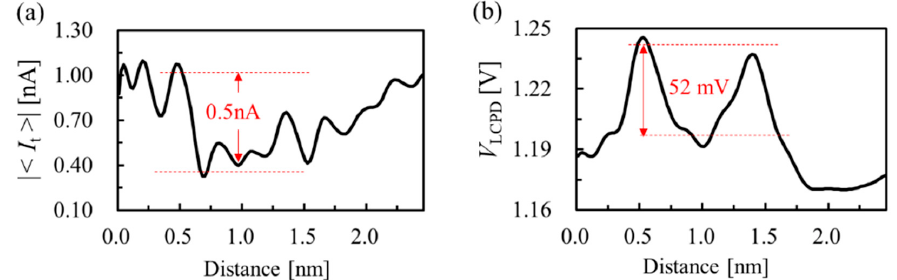
Figure 5. Multiple images of TiO 2 (110) surface with atomic resolution and corresponding line profiles. ( a ) Frequency shift ( ∆ f ) image, ( b ) tunneling current ( < I t > ) image and ( c ) local contact potential difference ( V LCPD ) image. ( d , e ) The line profiles along the blue line on the surface in (b,c). ( f 0 = 805 kHz, Q = 27623, ∆ f = − 260 Hz, V DC = 1.3 V, V AC = 1.5 V, A = 500 pm, size: 3.5 × 3.2 nm 2 ).